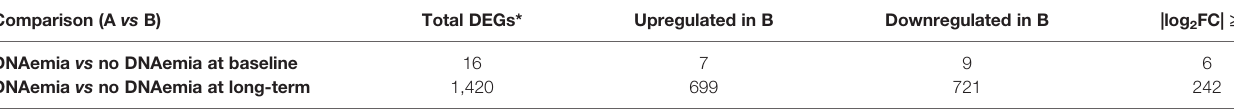
TABLE 4 | Differential expression results for DNAemia versus no DNAemia at baseline and at the long-term. Comparison (A vs